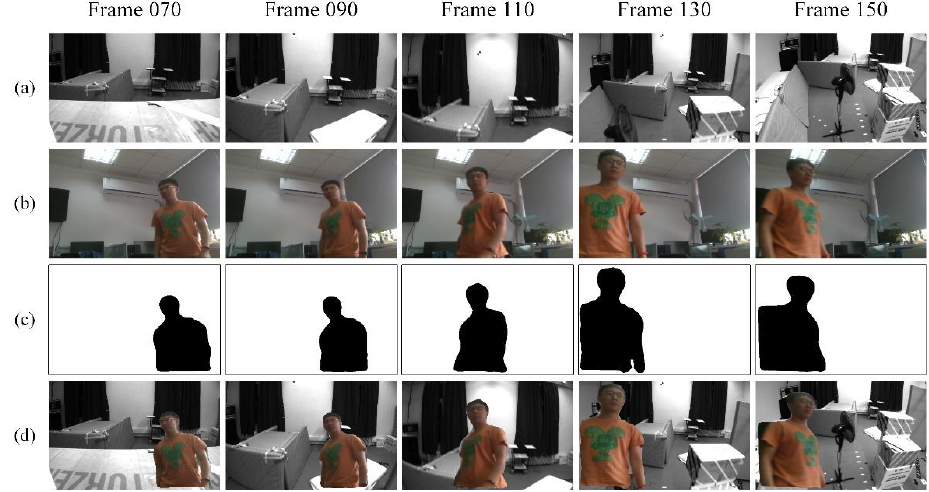
Figure 10. The processing of the V202_syn sequence. ( a ): Images in original Euroc V2_02 sequence. ( b ): Images collected by ourselves, containing a pedestrian. ( c ): Sematic images obtained by Mask-RCNN. ( d ): Images in the modified V202_syn sequence.